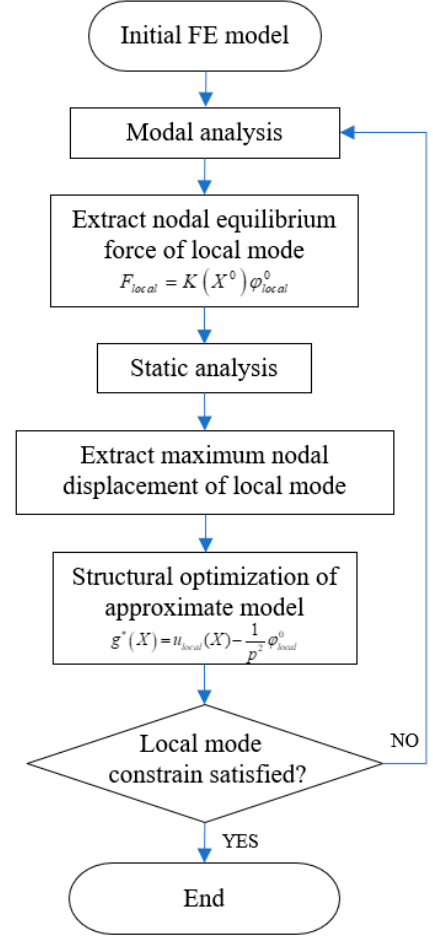
Figure 1. Optimization flowchart.